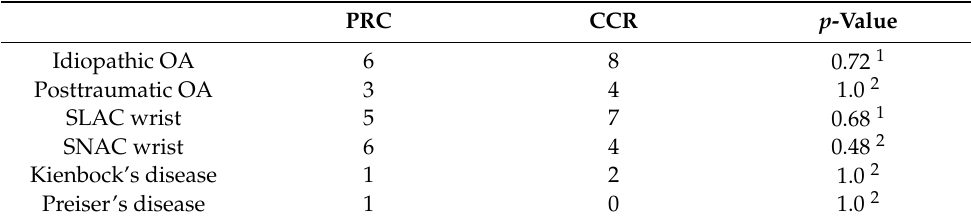
Table 2. Indications for TWA (Total wrist arthroplasty)